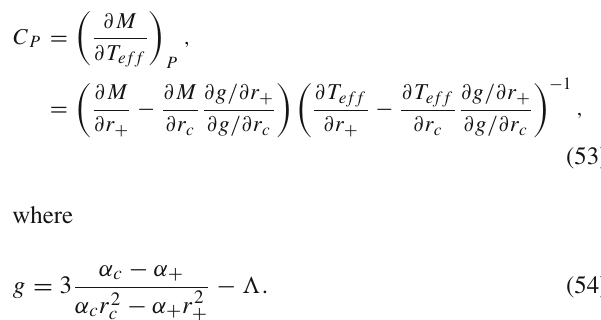
Fig. 10 We plot the effective temperature in terms of the event horizon radius r + , under the different values of the magnetic charge Q , with the cosmological horizon radius r c = 5. The blue, red, green and purple curves correspond to Q = 2, 1 . 5, 1, 0 .